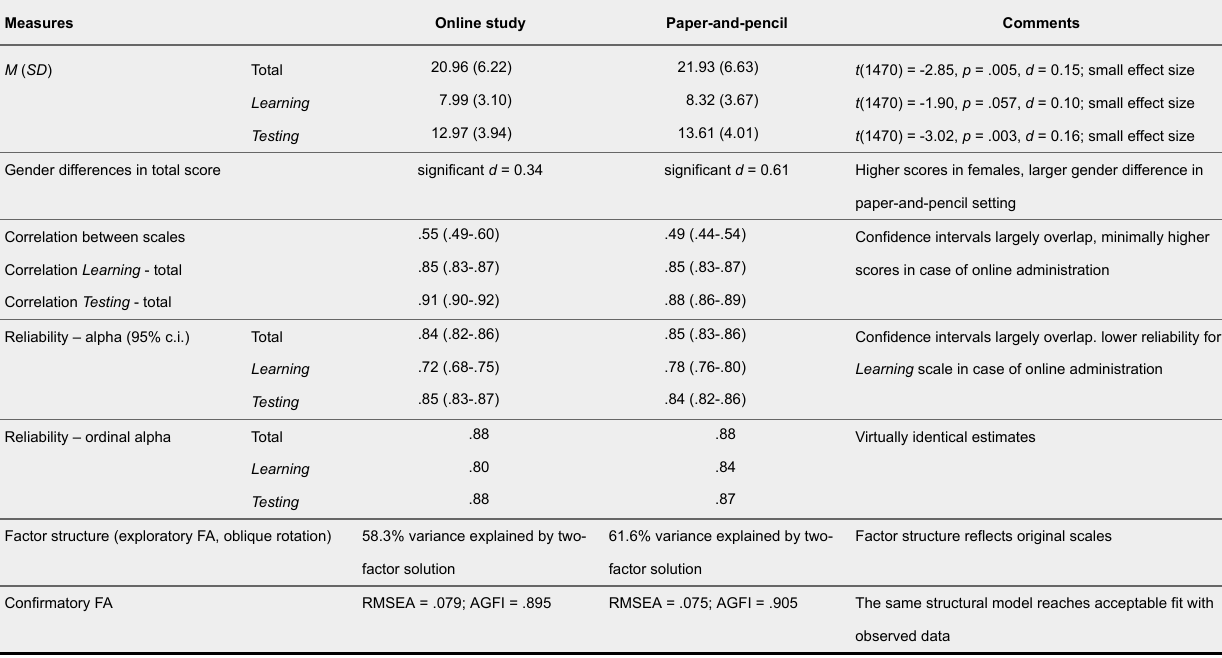
Measures Online study Paper-and-pencil Comments